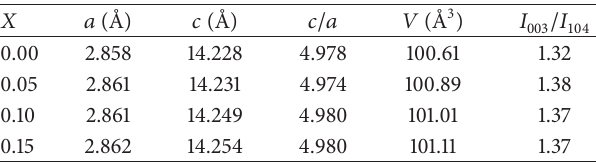
Table 1: Lattice parameters of the LiNi 1/3 Co 1/3 Mn 1/3 O 2−𝑥 Cl 𝑥 cath- ode